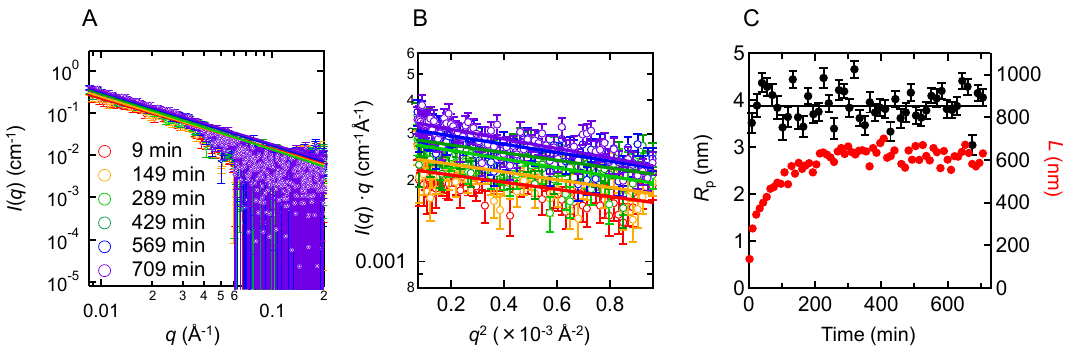
Figure 6. Characterization of the size and shape of prefibrillar aggregates at pH 5.2 monitored by SAXS. The measurement was performed at 1.40 mg/mL. ( A ) Double logarithm plots of the SAXS profiles at different time points. Solid lines indicate fitted lines using Equation (3) in Porod region. ( B ) Cross-section plots. Solid lines indicate fitted curves obtained using Equation (4). ( C ) Time changes of R p (black) and L (red), which were obtained from R c in panel B and the DLS data in Figure S4 using Equations (5) and (6). A solid line indicates the mean of the R p